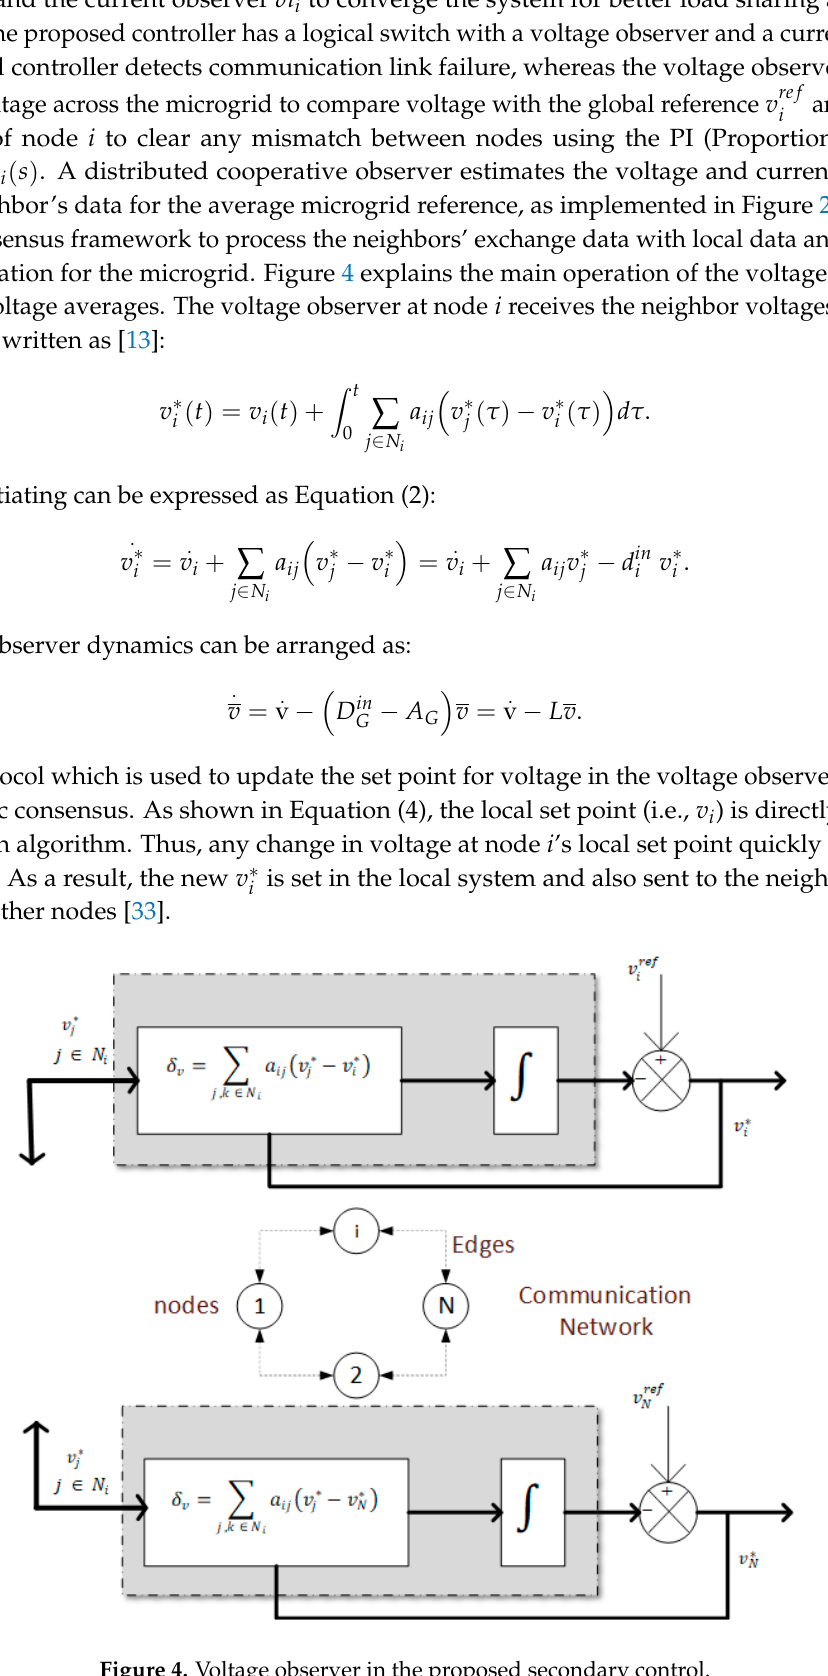
Figure 5. Proposed algorithm flow chart. 4.1. Single Converter model DC MG systems based on multiple DC–DC converters usually have high switching frequency. Therefore, the impact of non-linearity in switching frequencies is averaged out, and owing to this fact the converters are a model based on state average modeling, and consensus control is also approximated as continuous in the time domain. However, when a connection failure occurs, the delay is very large in comparison to the normal delay in a communication network. The small signal model for a Buck converter is shown in (7) [34–36]: (cid:4678) (cid:3279)(cid:3284) (cid:3279)(cid:3295) (cid:3279)(cid:3297) (cid:3279)(cid:3295) (cid:4679) = (cid:4678) (cid:2868)